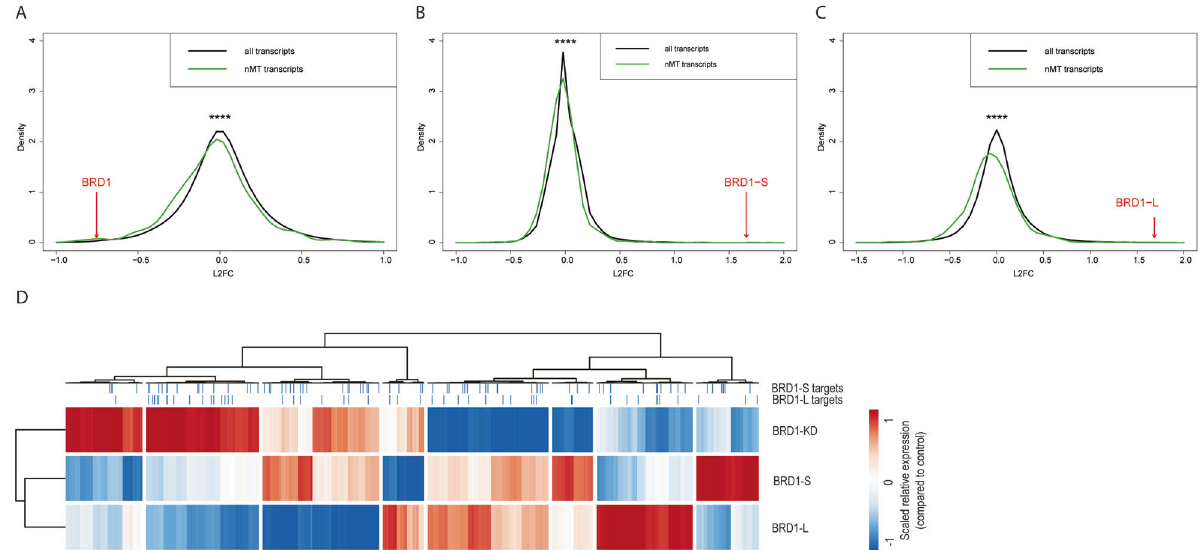
Fig. 1 Expression of nuclear-encoded mitochondrial (nMT) transcripts upon BRD1 under- or overexpression. A – C The expression of nMT transcripts in HEK293T cells with A BRD1 underexpression (BRD1-KD) or B overexpression of BRD1-S or C overexpression of BRD1-L isoforms were compared to the parental HEK293T control cell line by plotting log2 fold change (L2FC) of all transcripts (black, n all = 17,328) and nMT transcripts (green, n nMT = 954). In all three comparisons, a signi fi cant shift in the expression pro fi les towards negative L2FC for nMT transcripts was observed, as determined by the Mann – Whitney U test. **** p < 0.0001 ( p < 10 − 8 ). Red arrows indicate expression levels of respectively, total BRD1 (BRD1), BRD1-S, and BRD1-L splice variants. D Relative changes in mRNA levels for nMT genes in BRD1-KD, BRD1-S, and BRD1-L cells compared to naïve HEK293T control cells. Columns represent nMT genes and rows represent BRD1-KD, BRD1-S, and BRD1-L cells. L2FC values are scaled (unit variance scaling) and column-centered. Clustering is based on correlation. Top panel marks, respectively, BRD1-S and BRD1-L target